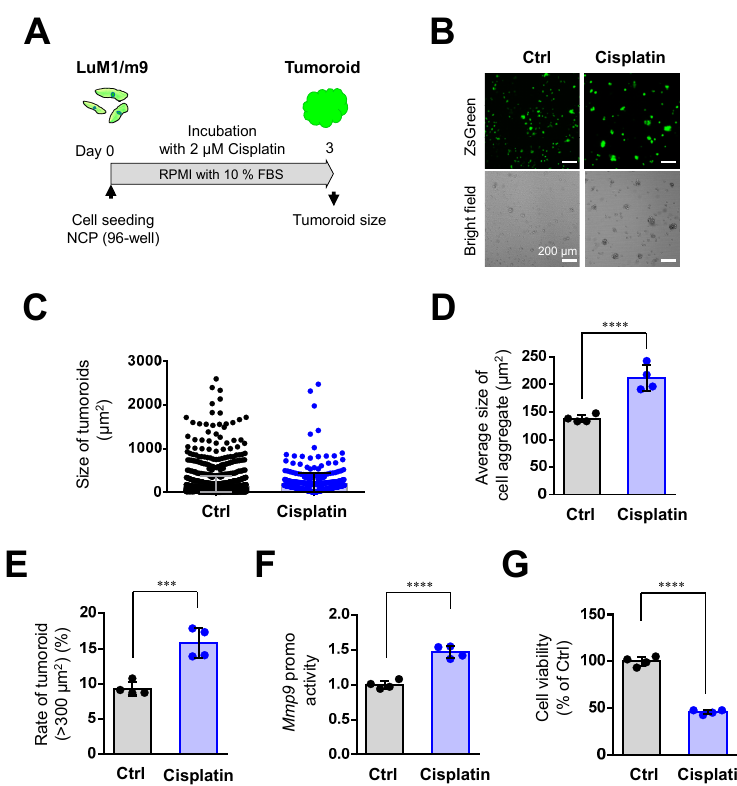
11 of 18 Figure 4. Cisplatin (at 2 μ M) promoted the tumoroid formation of mCRC cells: ( A ) a scheme of the experimental protocol used for panel ( B – G ). LuM1/m9 cells were cultured with 2 µ M Cisplatin for 3 days in a medium containing 10% FBS; ( B ) representative images of cell aggregates. Scale bars, 200 μ m; ( C ) column scatters plotting of tumoroid size. Representative data from a single well were shown; ( D ) average tumoroid size. n = 4 independent culture wells; ( E ) the rate of tumoroids larger than 300 µ m 2 . n = 4 independent culture wells; ( F ) Mmp9 promoter activity. n = 4 independent culture wells; and ( G ) cell viability. n = 4 independent culture wells. *** p < 0.001, **** p < 0.0001.